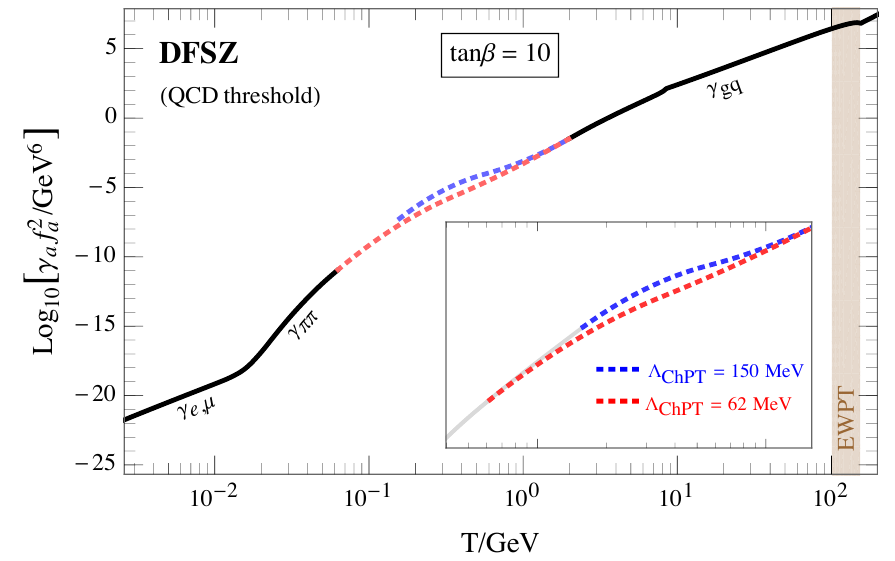
Figure 6 . DFSZ axion production rate across the QCDPT. We set tan β = 10 . QCD is perturbative for T > Λ = 2 GeV and the rate is controlled by both gluon and quark scatterings. Right below N confinement, but still above T ∼ 10 MeV , pion scatterings ( γ lepton scatterings ( γ ) is the only production channel available. We interpolate for the two values e,µ Λ = 62 MeV (dashed red) and 150 MeV (dashed blue). The brown region identifies the ChPT